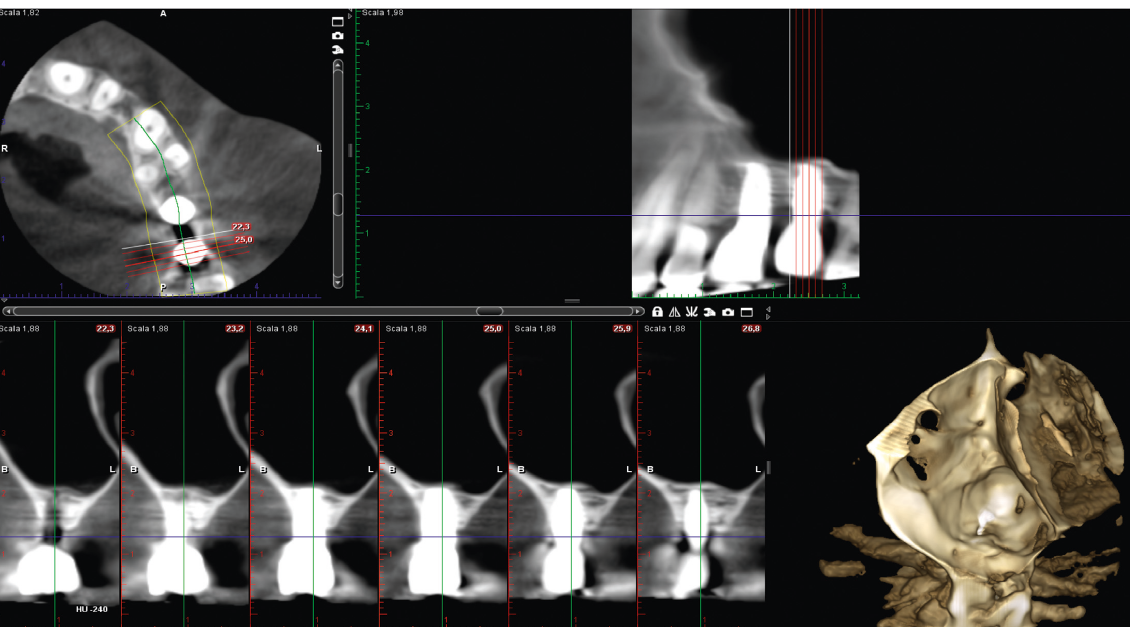
Figure 8: Implant site #26 CT scan at 4 years.